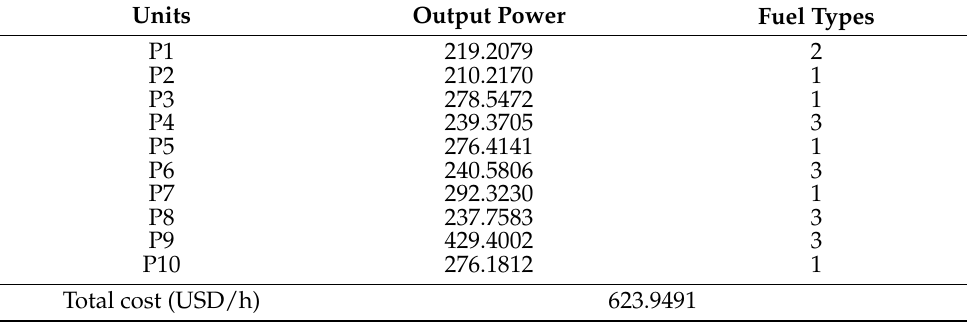
Table 4. The best decision variables for Case A-type 2 obtained by G-SCNHGWO